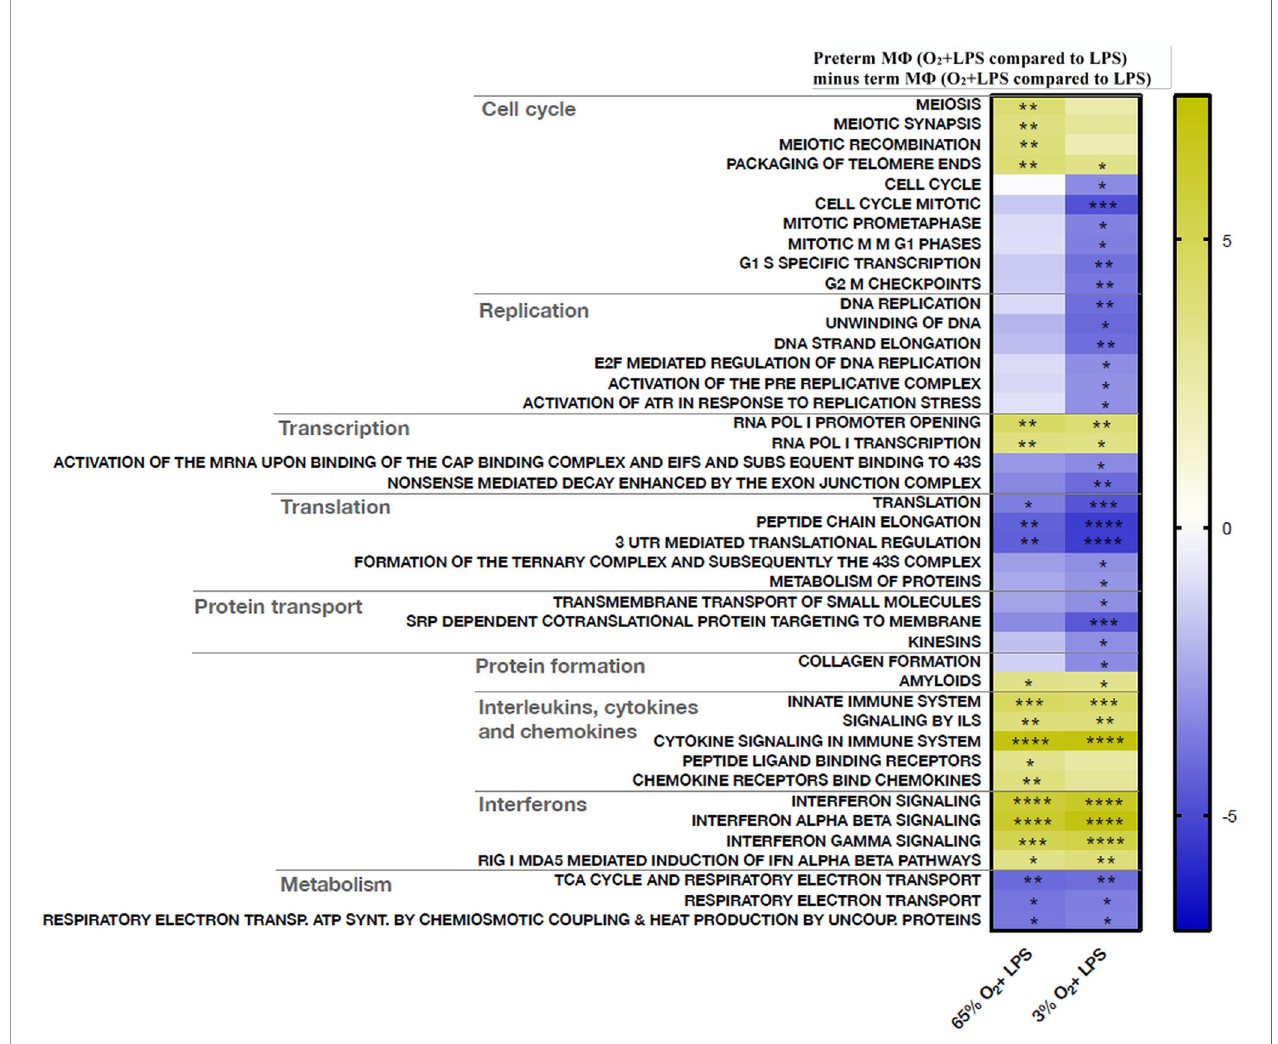
FIGURE 9 | Transcriptome pathway pro fi le of preterm macrophages (M F ) exposed to various oxygen concentrations and LPS compared to term M F . For priming with 65% O 2 or 3% O 2 followed by LPS stimulation, preterm and term M Ф were incubated for 72 h (48 h 65% O 2 or 3% O 2 followed by 24 h 21% O 2 with or without LPS). The heatmap compares the responsiveness to oxygen priming between different gestational age groups by comparing the difference of O 2 +LPS with LPS alone from preterm M F subtracted by the same difference from term M F (LPS values were re-used from because double-hit conditions were included in those experiments). The pathway pro fi le is based on the REACTOME gene sets (provided by MSIGDB library) after input of differentially regulated genes (p adj < 0.05) from preterm and term M Ф . It shows the “ mean of gene set ” -values which were signi fi cantly regulated in at least one double-hit condition vs. LPS indicated be an asteriks. The following categories were detected: cell cycle, replication, transcription, translation, protein transport and formation, innate immune system, and metabolism. (n=4 independent experiments with cells of four different donors (3 out of 4 donors are the same as Figure 6 ); “ mean of gene set ” test statistic, *p<0.05, **p<0.01, ***p<0.001, and